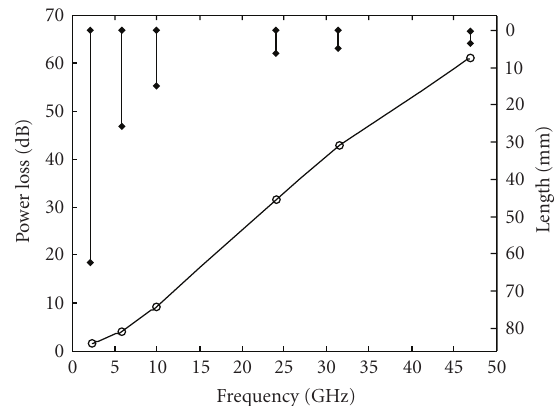
Figure 1: Power loss within 4 mm of skin. The corresponding half wavelengths are also shown.